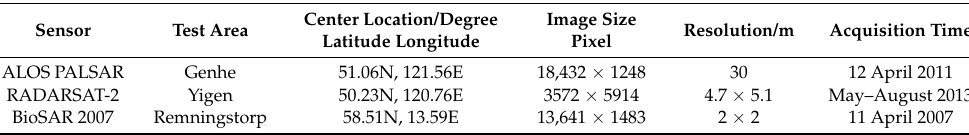
Table 1. Overview of experimental SAR